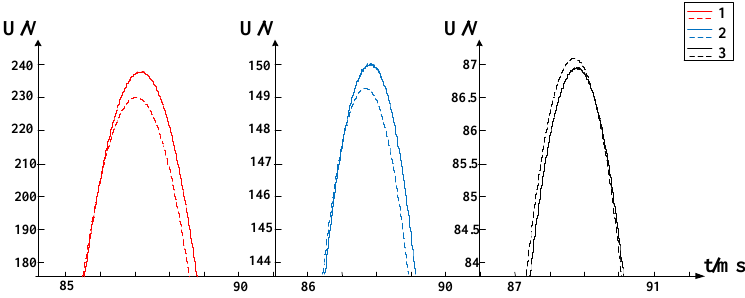
Figure 13. Adjacent load voltages of 3 cases from 85 ms to 90 ms.